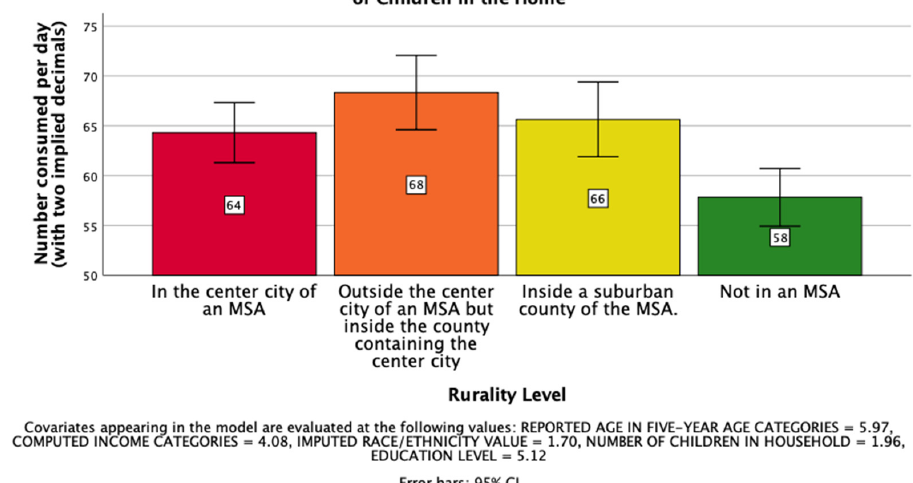
Figure 1. National Mean Daily Fruit Juice Intake .